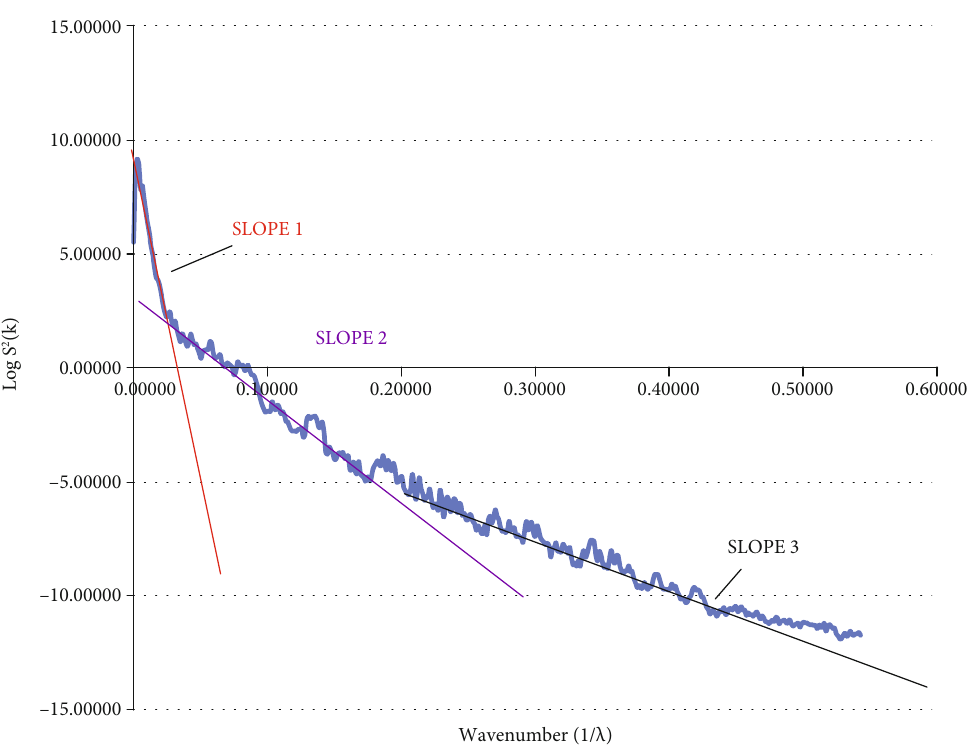
Figure 3: This plot illustrates the typical reduction in energy with increasing